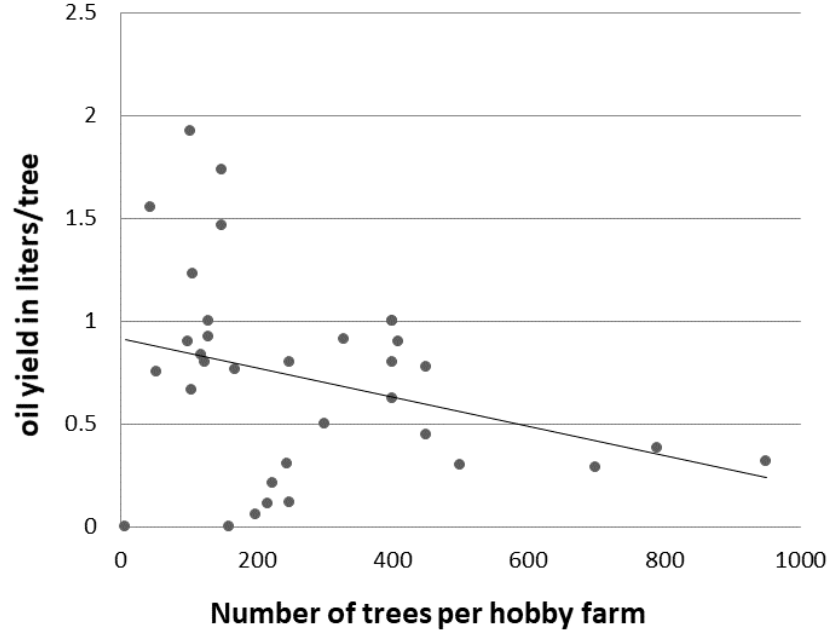
Figure 5. Production intensity, expressed as olive oil (L / tree) per the number of managed trees by the hobby farmers ( n = 33, two outliers deleted from the